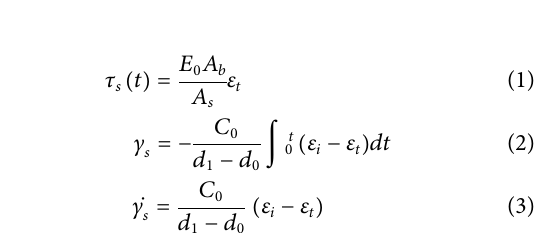
FIGURE 1 | The diagrams of hat-shaped specimen, (A) the geometry of hat-shaped specimen; (B) the sections of investigated specimens.